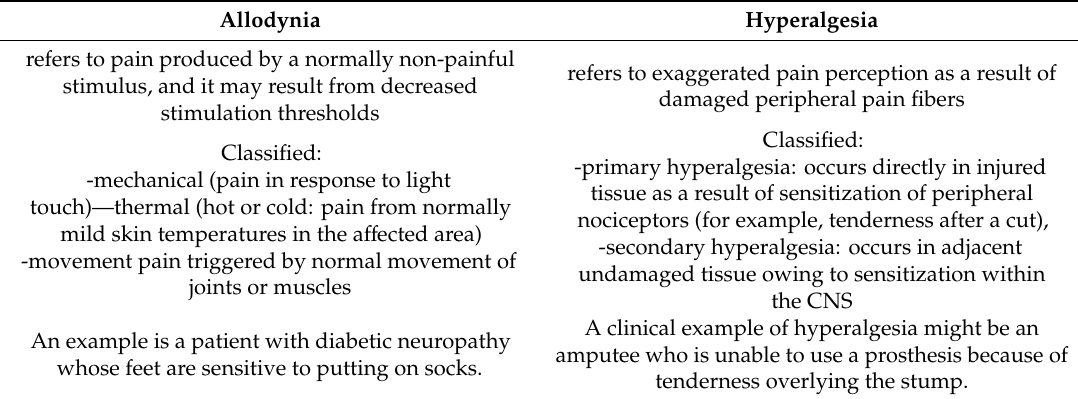
Table 3. Allodynia and